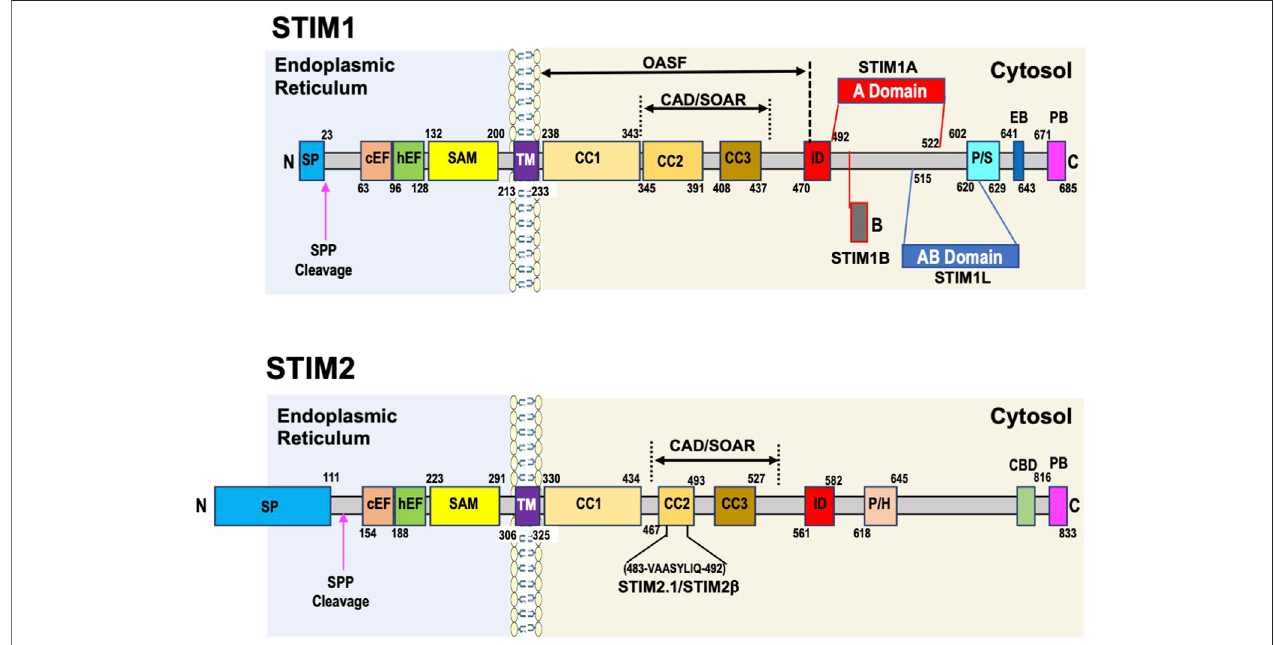
FIGURE 1 | Domain structure of human STIM1 and STIM2 proteins. STIM1 has a short signaling peptide (SP) at the N-terminus which is cleaved by a signaling peptidepeptidase (SPP) when the protein is localized to ERmembrane. Inthe endoplasmic reticulum the keydomains arecanonical and hidden EF hand domains (cEF, hEF) and the sterile alpha motif (SAM domain. Theseregions play acritical rolein regulating SOCE, with thecEF domain asthe sensor ofERCa 2+ ,and the hEF and SAM domains contributing to the initial conformation changes that are transmitted via the transmembrane domain (TM) to coiled coil (CC)1 domain, which releases the CAD/SOARregion(CRAC-activatingdomain/STIM-Orai-activatingregion),whichincludesCC2andCC3domain,facilitatingboththeextensionoftheC-terminaldomain towards the plasma membrane and STIM1 oligomerization, both of which are required for SOCE activation. Other important cytosolic domains include the inhibitory domain(ID),whichisinvolvedinCa 2+ dependentinhibitionofSOCE;theproline/serinedomain(P/S),whichcontainsmanyphosphorylationsitesthatcanregulateSTIM1 function; the End binding protein domain (EB) and the polybasic domain (PB) at the C-terminus. STIM1L is a splice variant found predominantly in striated muscle includestheinsertionofanactinbindingdomain(ABD)betweenaa515andaa620.STIM1AisanothersplicevariantwithinsertionofanAdomainjustaftertheIDdomain betweenaa492and522.STIM2architectureoverallisverysimilartoSTIM1withafewkeydifferences.LikeSTIM1ithascEF,hEF,andSAMdomainsintheendoplasmic reticulum, a TM domain, followed by CC1, CC2, and CC3 domains in the cytosol with a PB region at the C-terminus. As described in the text subtle differences in these regions lead to changes in function compared to STIM1. Differences with STIM1 include an unusually long signaling peptide region of ~100aa, a proline/histidine region (P/H),andacalmodulinbindingdomain(CBD)closetothePBregion. ItisunclearwhetherSTIM2contains anIDregion.TherearetwoknownSTIM2splicevariants, one STIM2.1 also known as STIM2 β involves the insertion of an 8 amino acid sequence (VAASYLIQ) within CC2